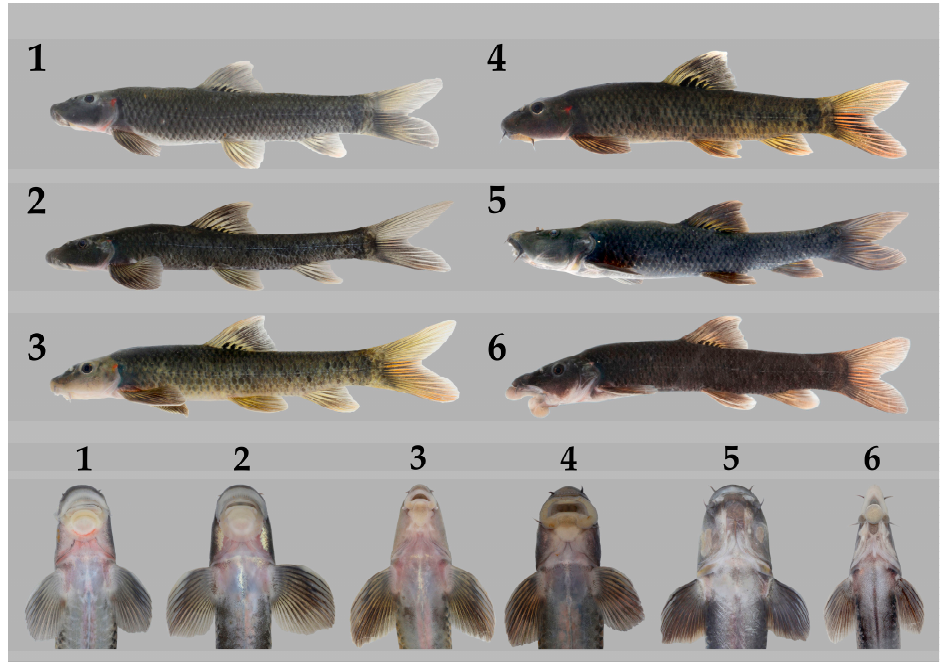
Figure 1. Garra ecomorphs from the Sore River: 1, ‘generalized’: 136 mm SL; 2, ‘stream-lined’: 99 mm SL; 3, ‘narrow-mouth’: 100 mm SL; 4, ‘wide-mouth’: 100 mm SL; 5, ‘predator’: 193 mm SL; 6, ‘thick-lipped’: 128 mm SL.